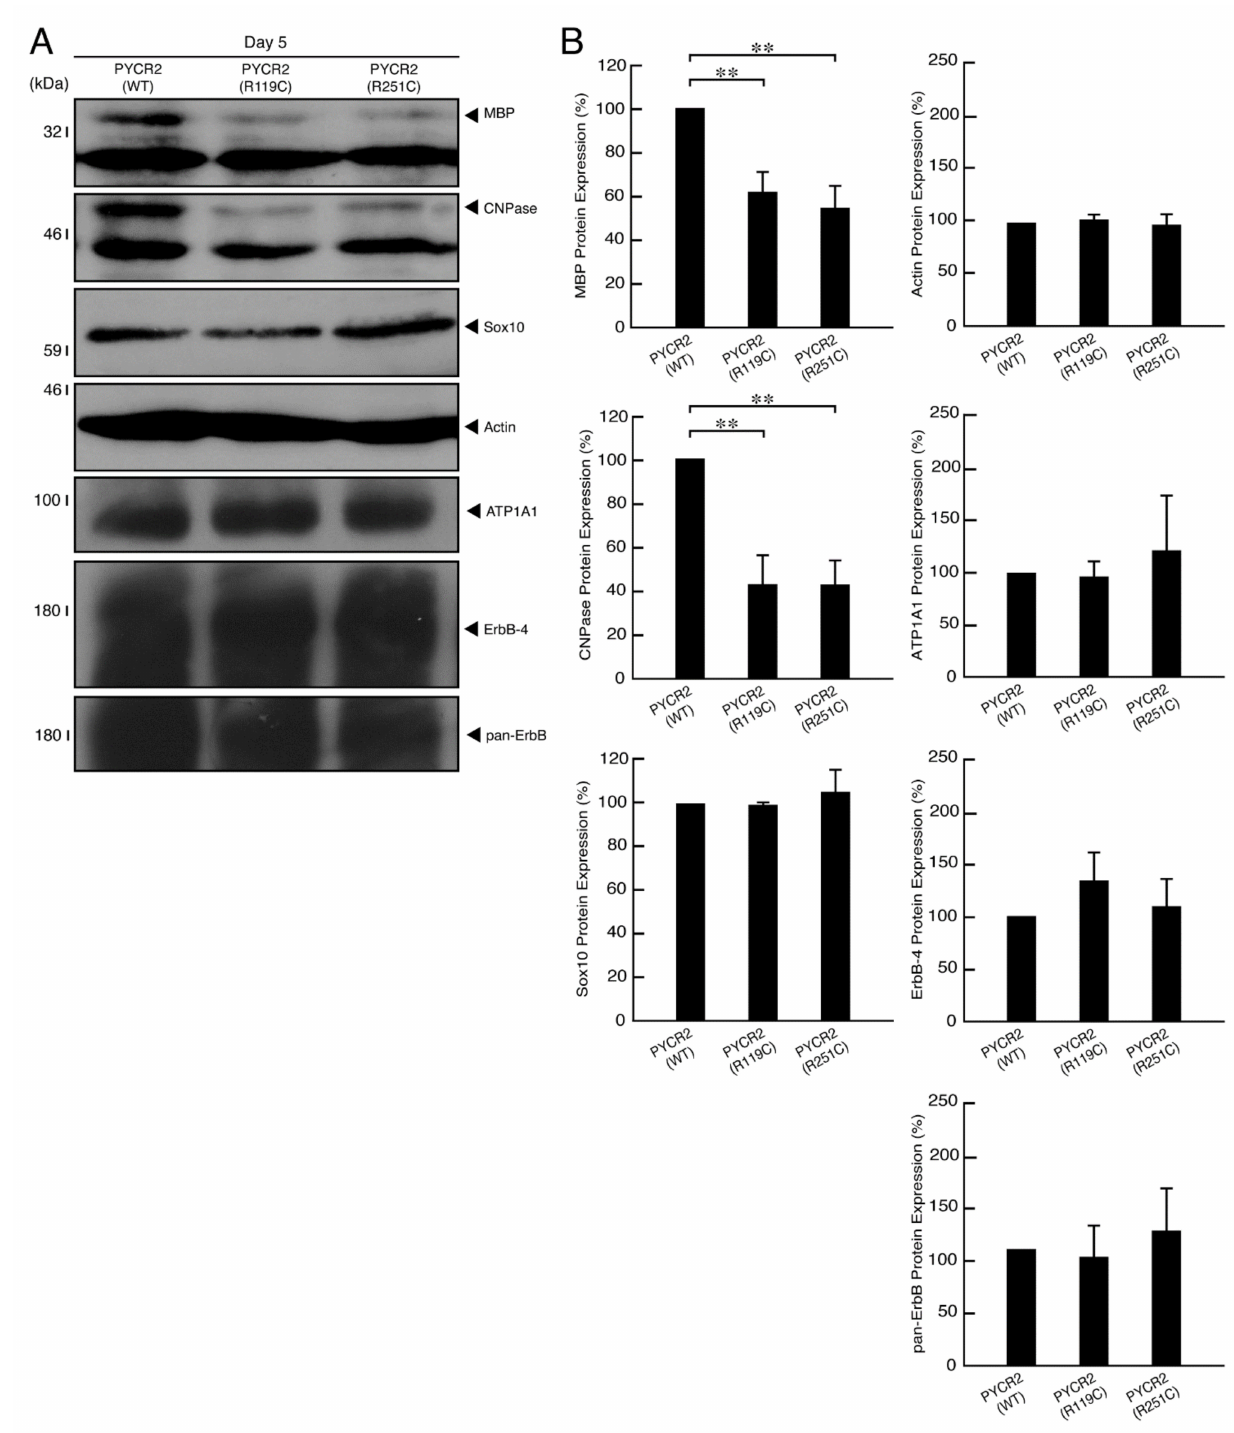
Figure 9. Cells expressing the R119C or R251C proteins, but not the wild type proteins, exhibit decreased expression levels of oligodendroglial cell differentiation marker proteins. ( A , B ) The lysates of the respective FBD-102b cells were immunoblotted with an antibody against oligodendroglial cell differentiation marker protein MBP or CNPase, oligodendroglial cell lineage marker Sox10. Additionally, antibodies against actin, ATP1A1, ErbB4, and pan-ErbB were utilized as the control protein markers. Their expression levels are shown statistically compared to their respective controls. (**, p < 0.01; n = 3 blots for MBP, CNPase, and actin, and n = 4 blots for ATP1A1, ErbB4, and